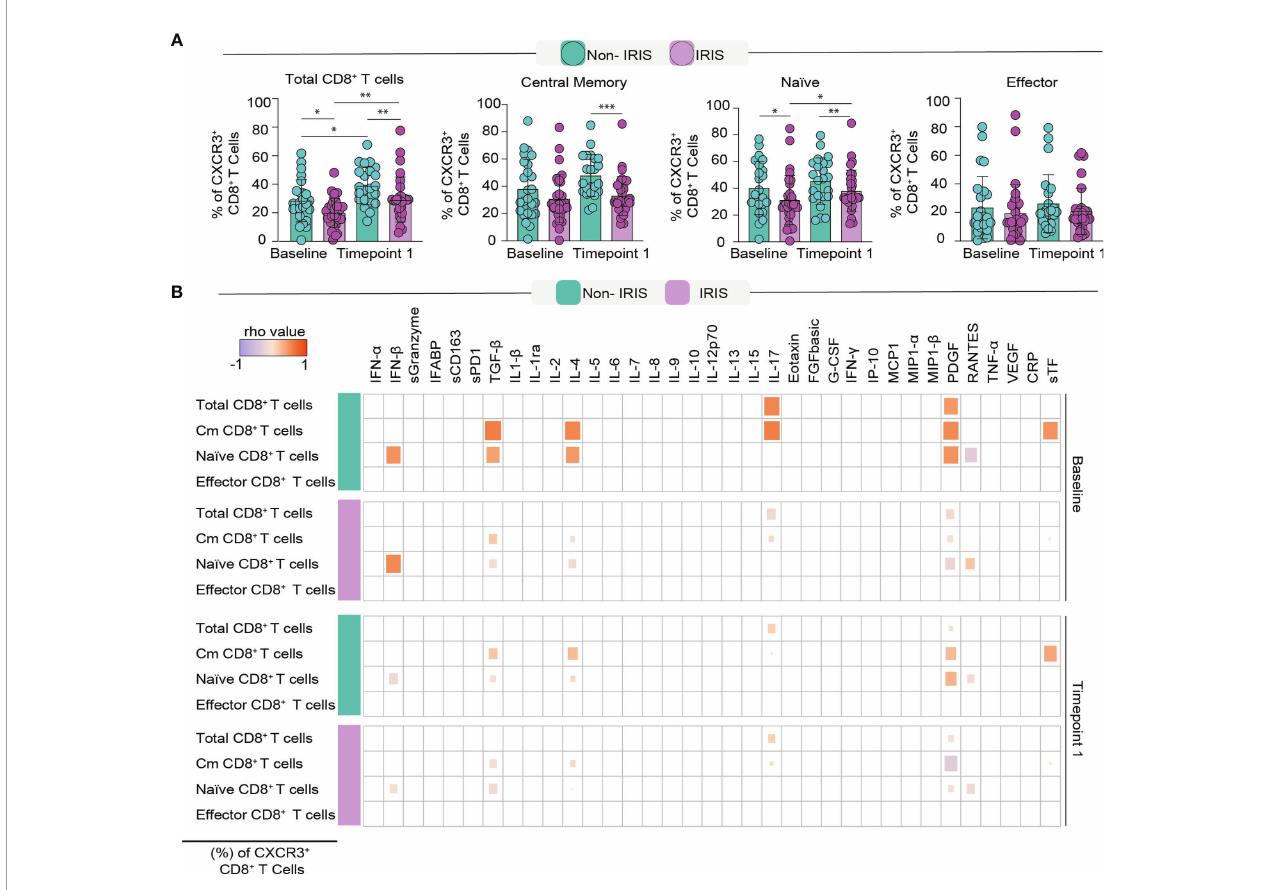
FIGURE 5 | Assessment of CXCR3 + memory CD8 + T cells in TB-IRIS and Non-IRIS individuals. (A) Frequencies of CXCR3 + in each memory compartment of CD8 + T cells. (B) A Spearman-based correlation matrix was employed to depict the strength of association among percentages of the memory subsets of CD8 + T cells and the concentration of pre-ART in fl ammatory molecules in Non-IRIS and TB-IRIS subjects. Statistically signi fi cant correlations (P<0.05) after adjustment for multiple measurements are highlighted as orange squares (positive correlations) or purple squares (negative correlations). *p < 0.05, **p < 0.01, ***p <